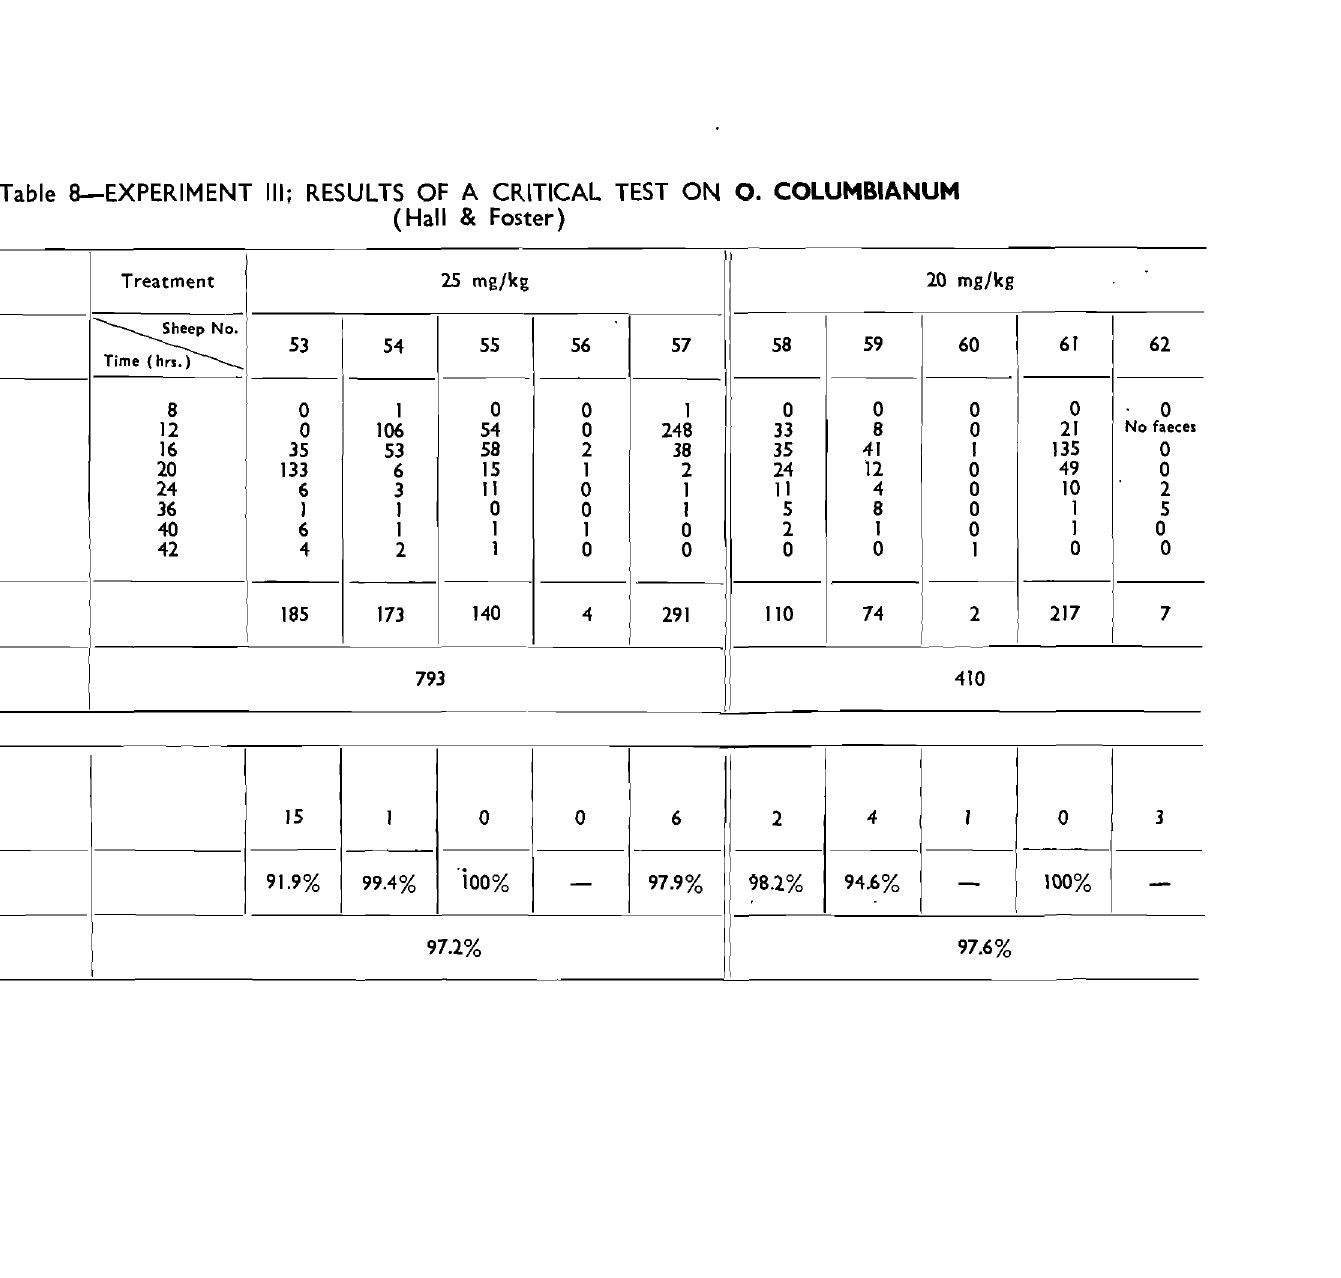
Table 8-EXPERIMENT III; RESULTS OF A CRITICAL TEST ON O. COLUMBIANUM (Hall &